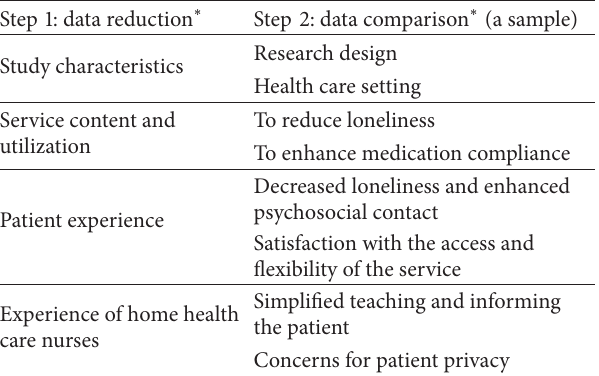
Table 1: Data abstraction and analysis ∗